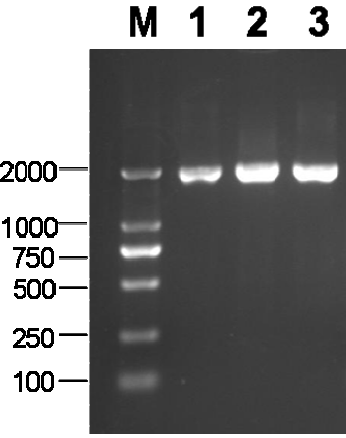
Figure 1. PCR product of MeVINVs (M: 2000 bp DNA marker). Lanes 1–3: PCR product of MeVINV1-3 ,